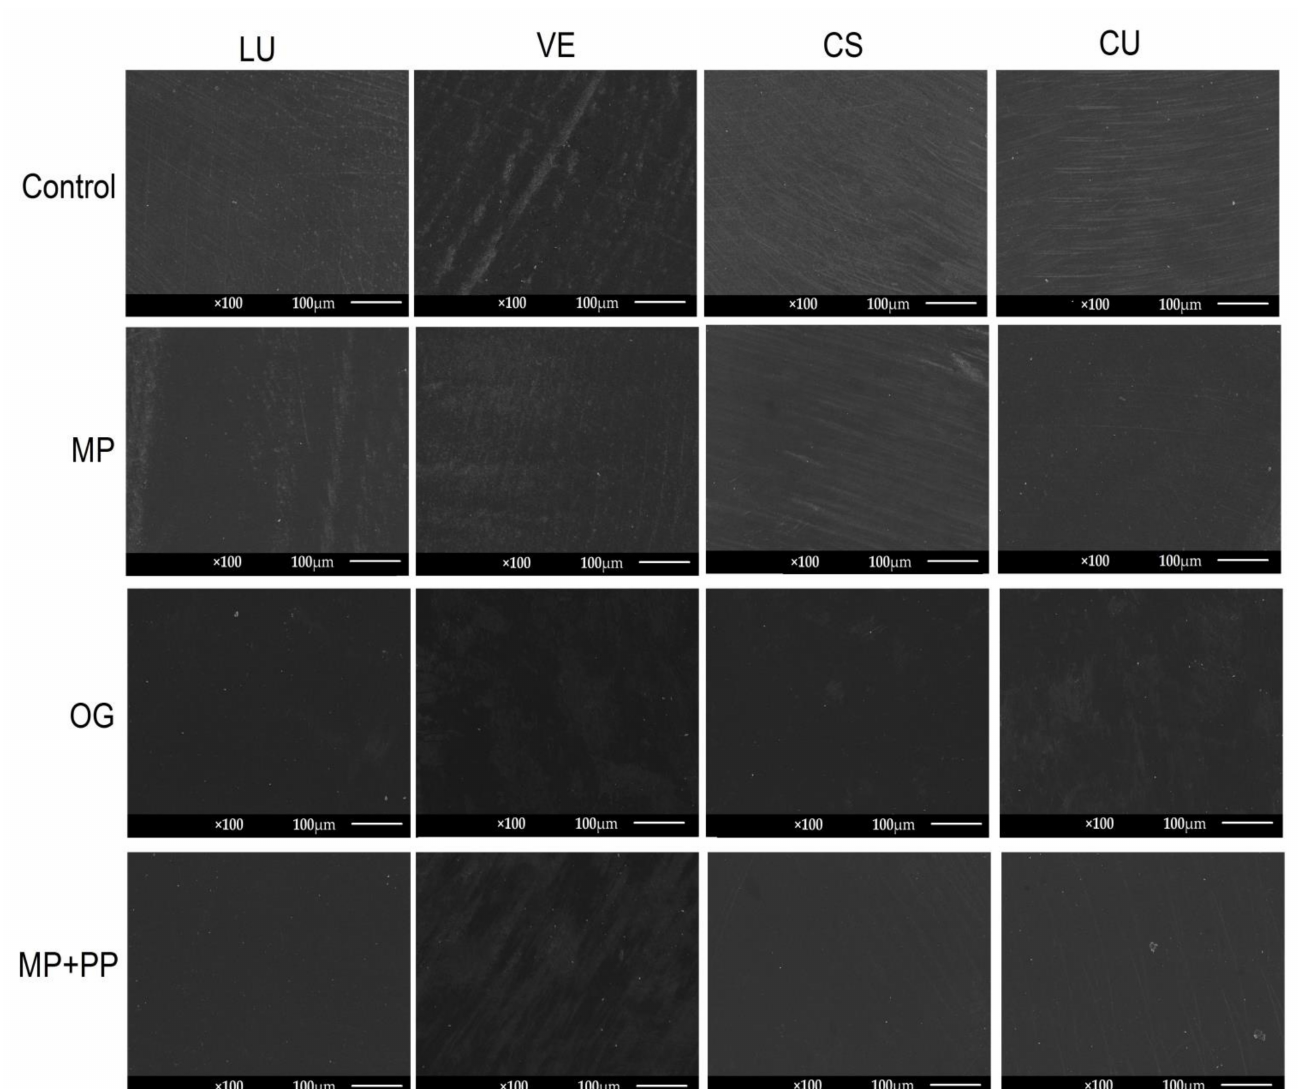
Figure 4. Scanning electron microscopy micrographs of the CAD/CAM materials after surface treatment.